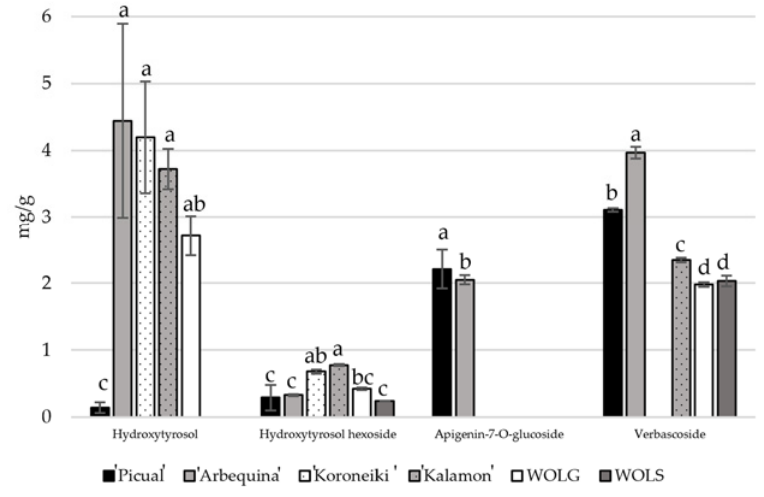
Figure 3. Concentrations (mg/g) of other phenolic compounds contained in dried olive leaves. WOLG: wild olive leaves ( O.e . spp. oleaster ) from Greece; WOLS: wild olive leaves ( O.e . spp. oleaster ) from Spain. For each compound, different lower case letters indicate significant differences among genotypes according to Tukey’s HSD test ( α <